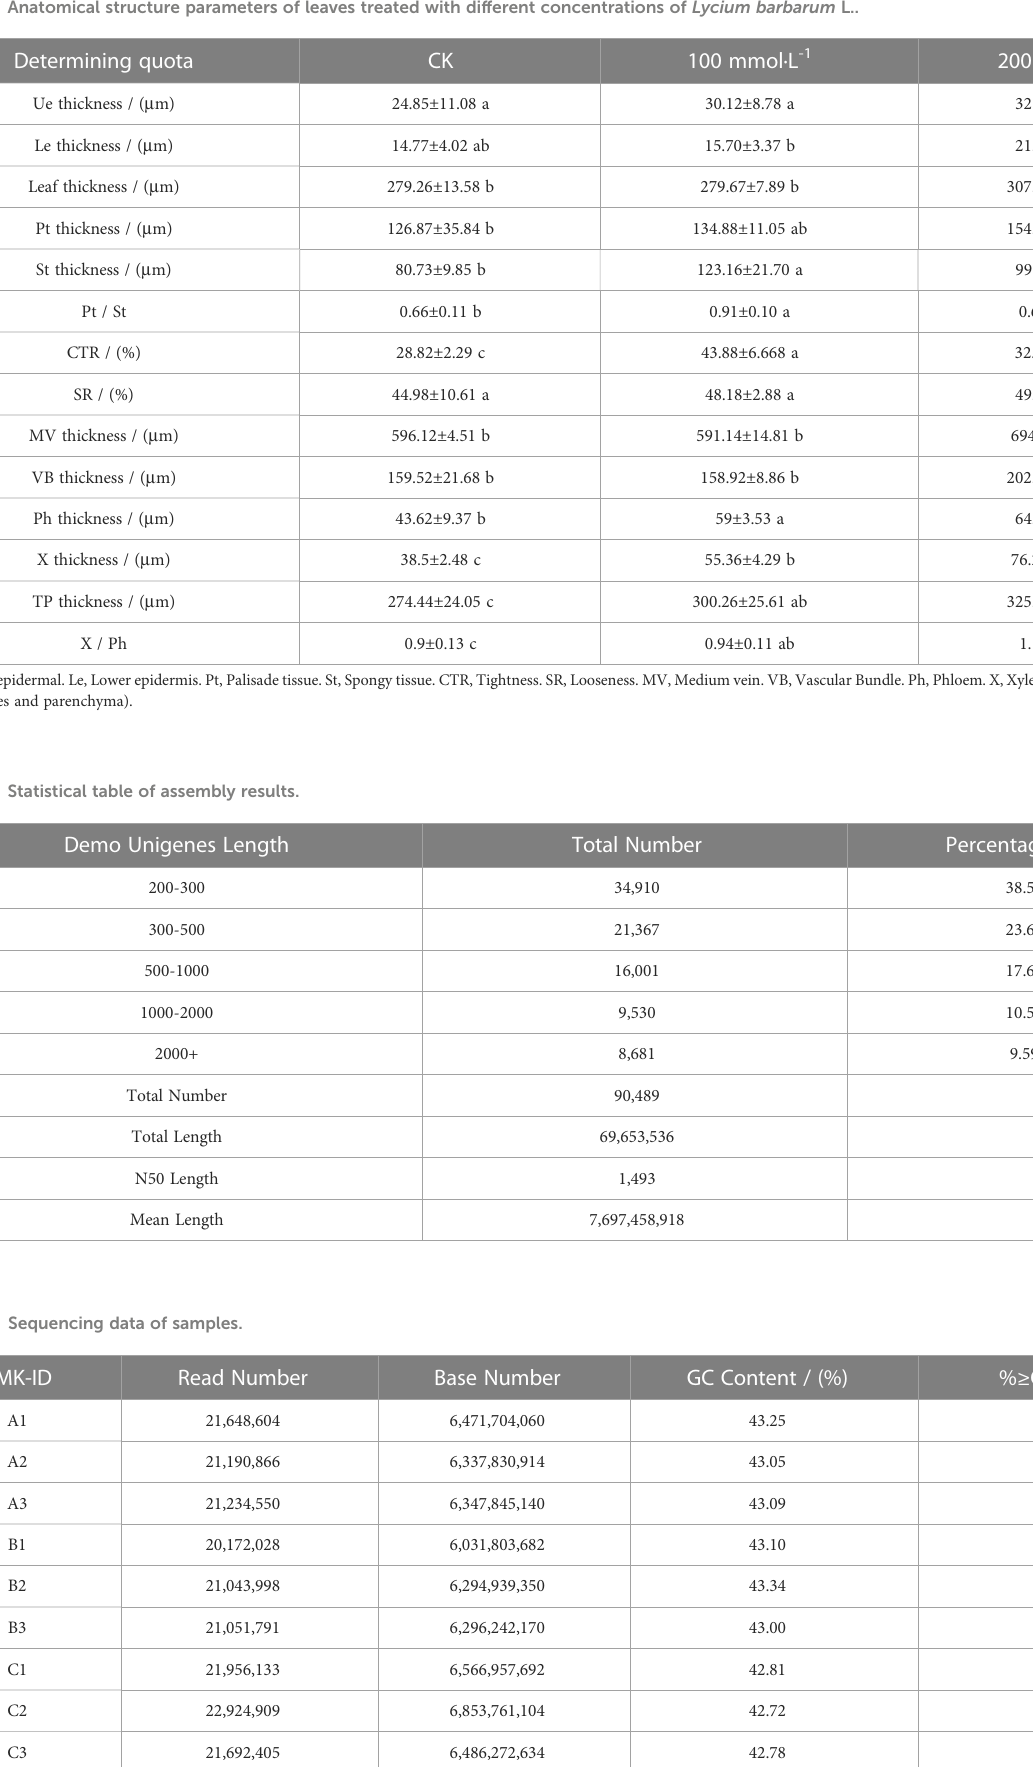
TABLE 2 Anatomical structure parameters of leaves treated with different concentrations of Lycium barbarum L..